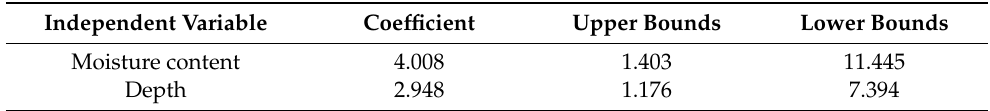
Table 4. Dominance ratio of smoldering occurrence probability by logistic regression (upper and lower limits of 95% confidence interval).